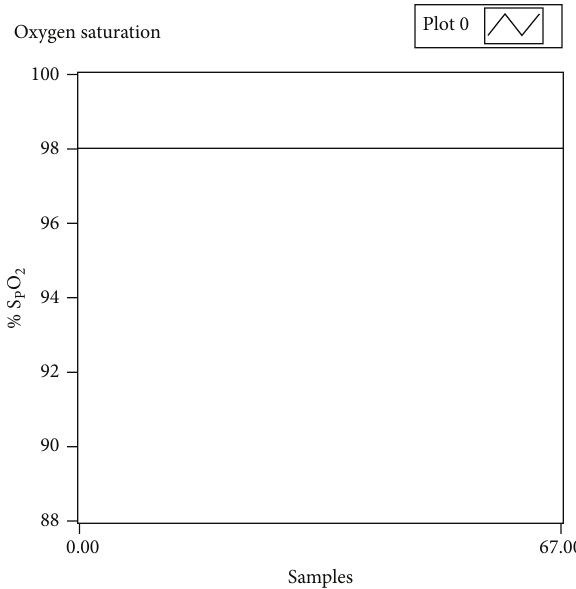
Figure 21: Oxygen saturation in the MCT for Patient 2 obtained in LabVIEW.